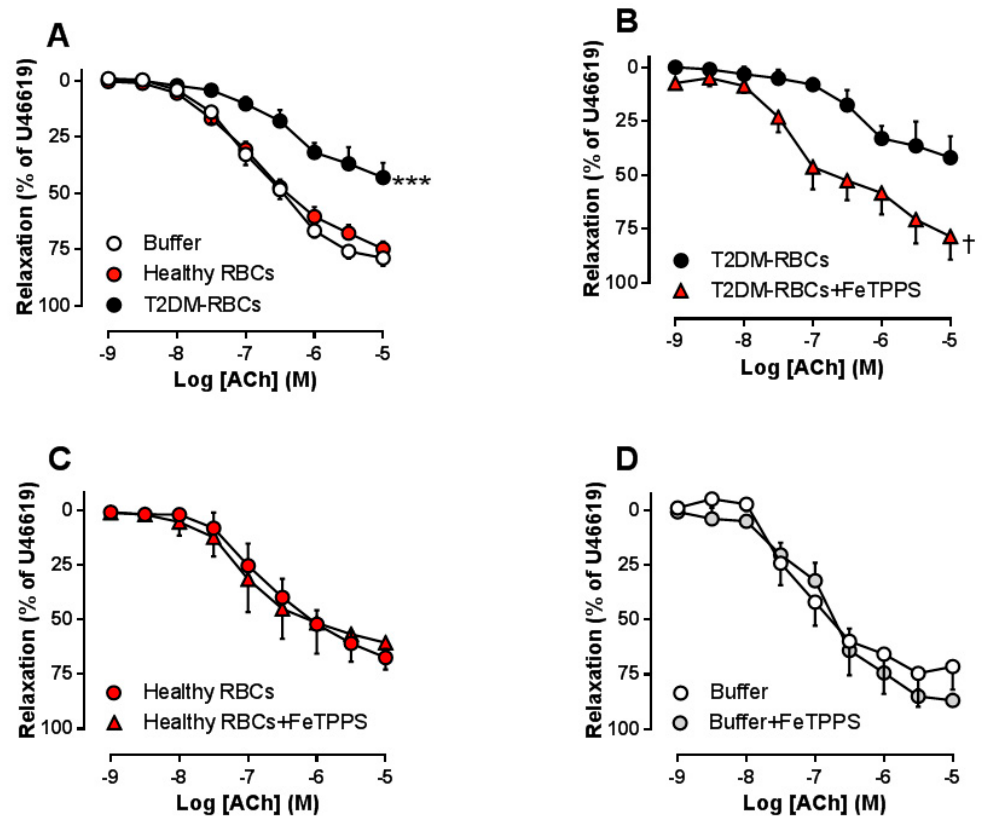
Figure 1. E ff ect of red blood cells from type 2 diabetes patients (T2DM-RBCs), healthy subjects (Healthy Red Blood Cells (RBCs)) or only bu ff er on endothelium-dependent relaxation (EDR) in rat aortas induced by acetylcholine (ACh) (( A ), n = 9–16). The peroxynitrite scaveger FeTPPS was co-incubated with T2DM-RBCs (( B ), n = 6), Healthy RBCs (( C ), n = 3) and bu ff er (( D ), n = 3). Values are mean ± SEM. *** p < 0.001 vs. Healthy RBCs or Bu ff er; † p < 0.05 vs. T2DM-RBCs.